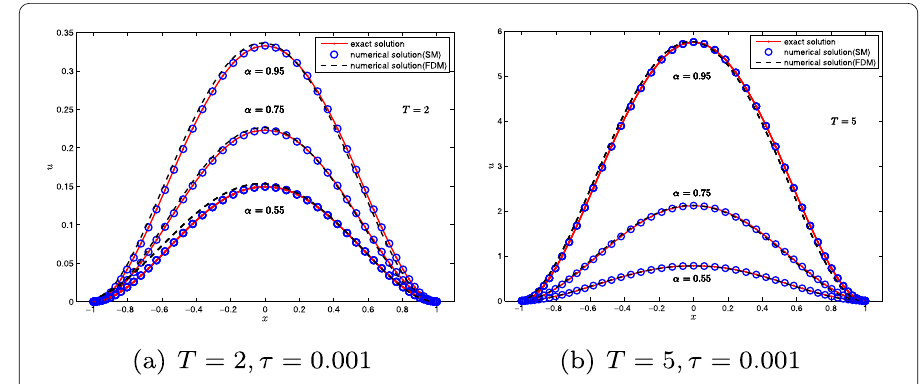
Figure 2 Comparisons of the exact solution with the numerical solutions of spectral method and finite difference method for Example 1 with different α and T , where N = 50